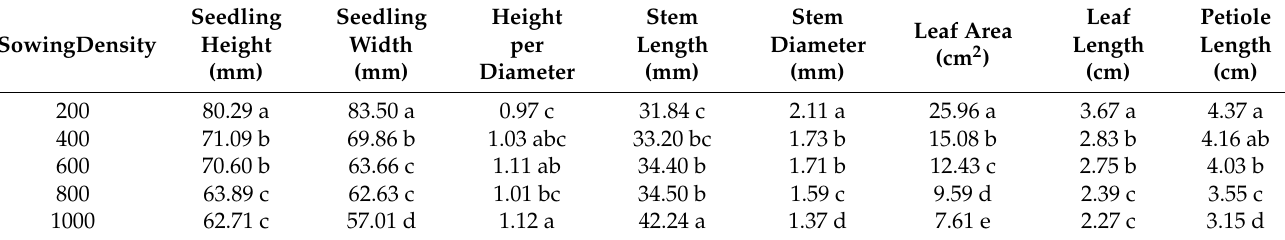
Table 1. The effect of sowing density on seedling performance.